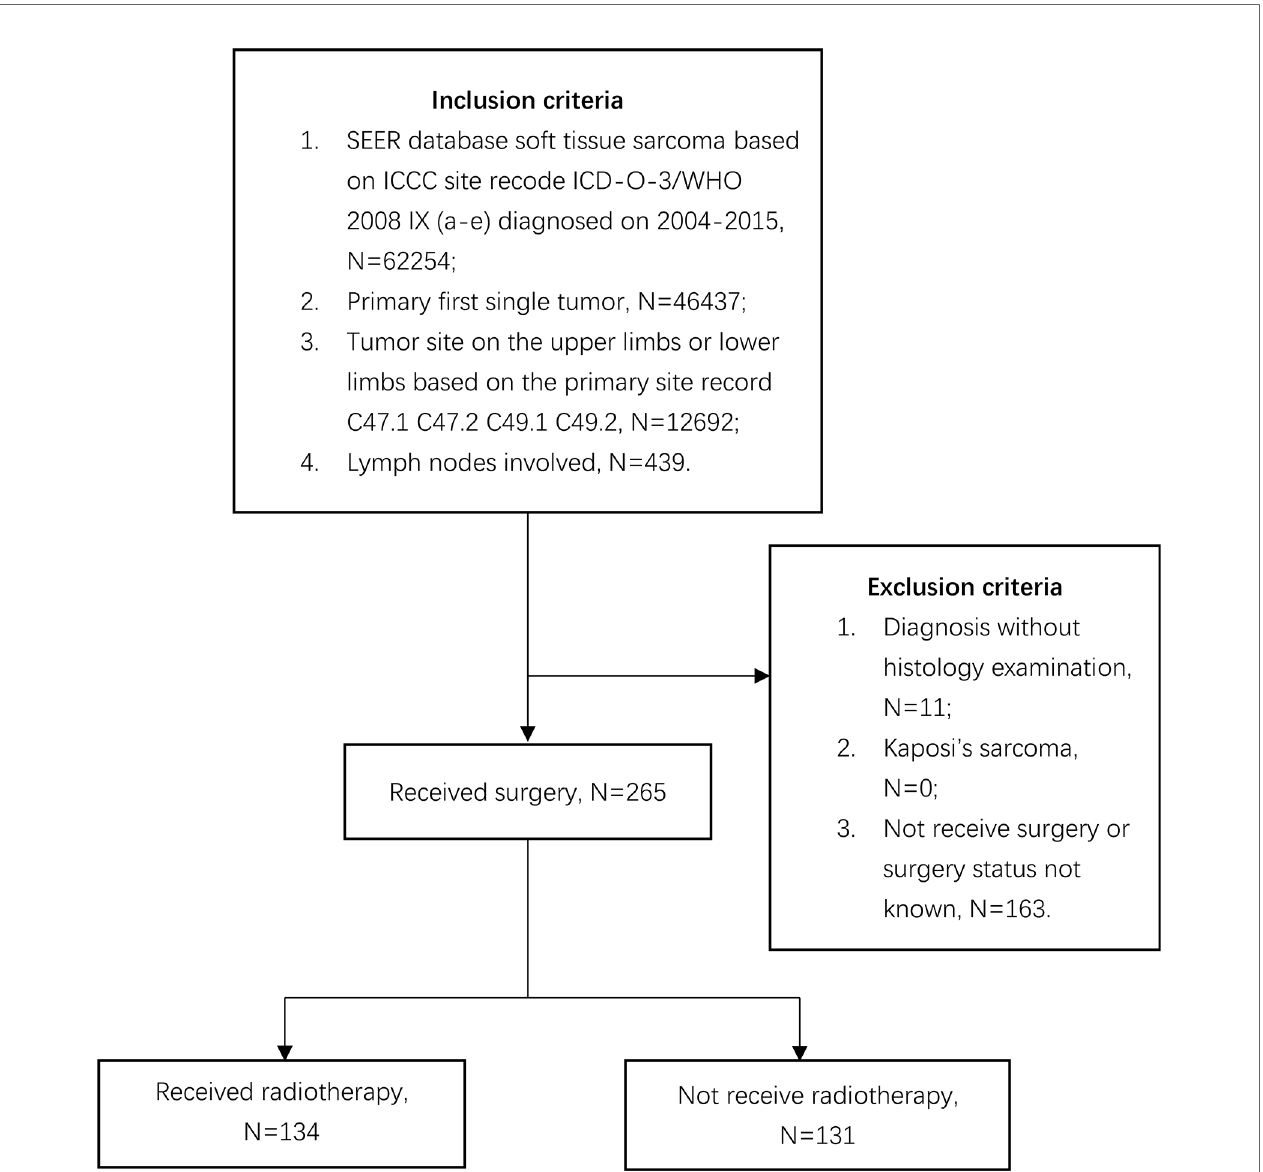
FIGURE 1 | Flow diagram demonstrating the inclusion and exclusion criteria used to select soft tissue sarcoma of extremities with regional lymph nodes involved cases using the SEER 18 population-based cancer